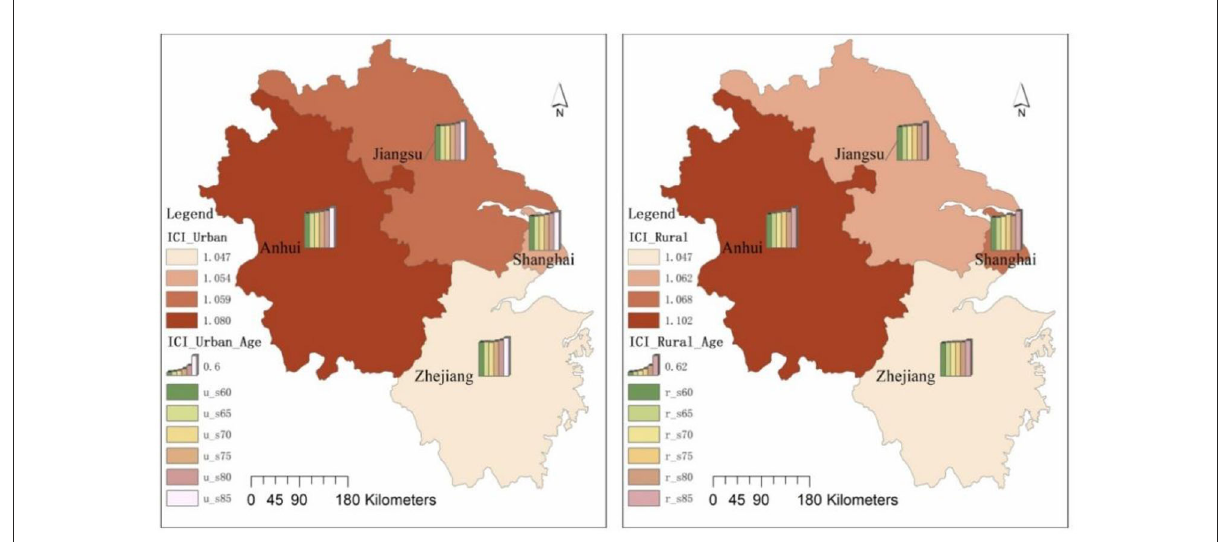
FIGURE5 Urban and rural incontinence indices for elderly people in Jiangsu, Shanghai, Zhejiang and